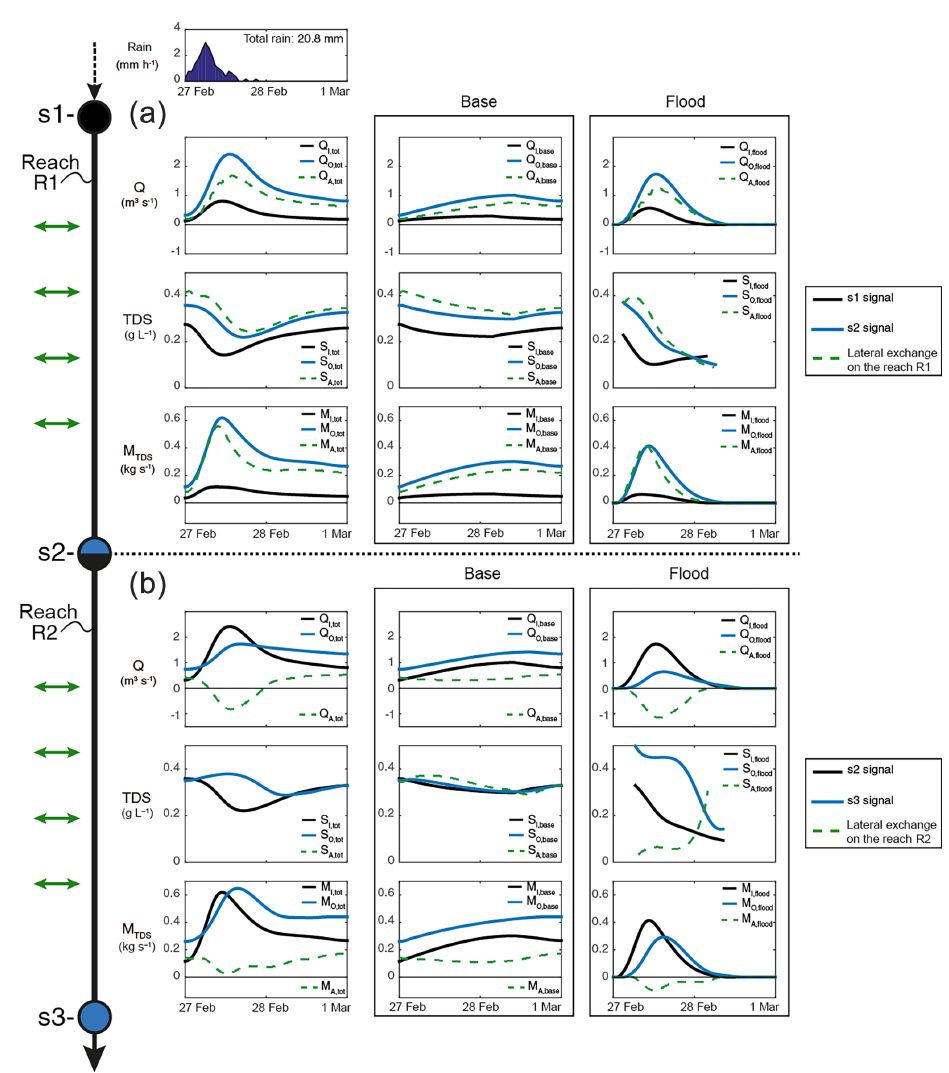
Figure 6. Framework application on the event no. 1 in high-flow condition along the two reaches R1 (a) and R2 (b) . Total flow and fluxes, base component and flood component are represented in the first, second, and third column,